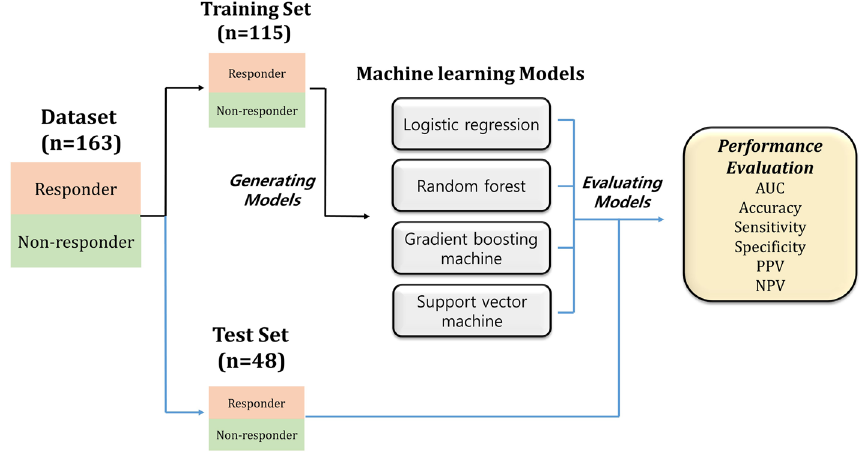
Figure 1. Prediction modeling and evaluation process. The total subjects (n = 163) were randomly divided into training and test sets by 7:3 ratio. The training set (n = 115) was used to derive the four prediction models: logistic regression (generalized linear model), random forest, gradient boosting machine, and support vector machine. Then, each model was applied to predict the surgical success for the subjects in test set (n = 48); surgical success was defined as a postoperative AHI < 20 and a ≥ 50% reduction in preoperative AHI. The performance of each model was evaluated by the true reference (surgical outcomes in their postoperative PSG or HSAT). AUC area under curve, PPV positive predictive value, NPV negative predictive